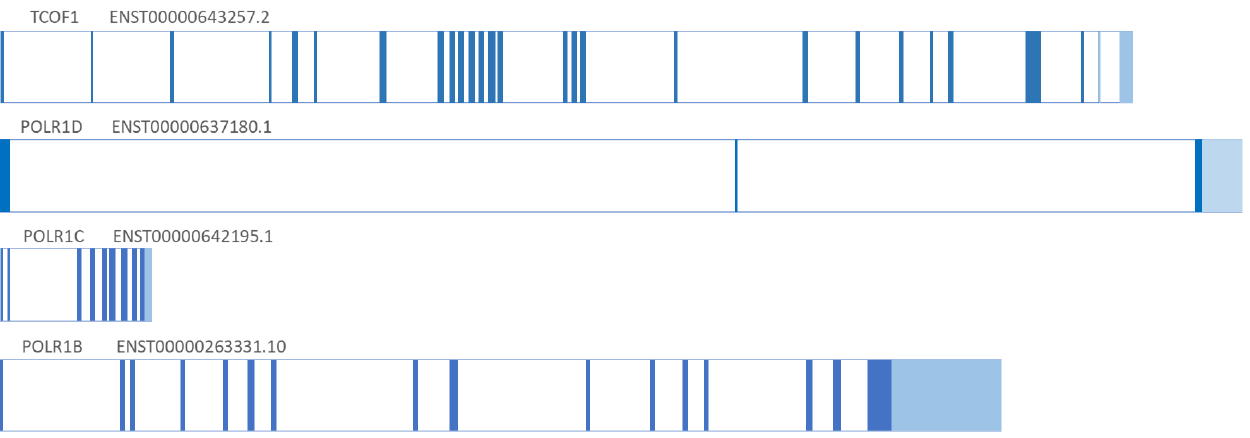
Figure 1. Genetic structure of genes responsible for TCS. Ref. [20] www.ncbi.nlm.nih.gov/gene (accessed on 5 August 2021); [21] http://www.ensembl.org (accessed on 5 August 2021).